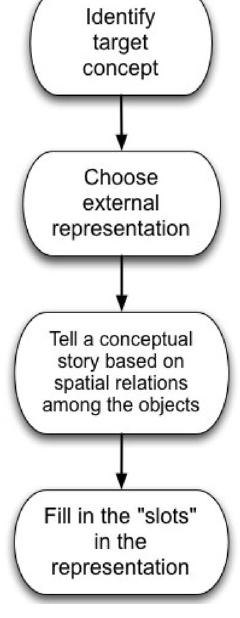
FIG. 4. Schematic diagram of some moves in the epistemic game Pictorial